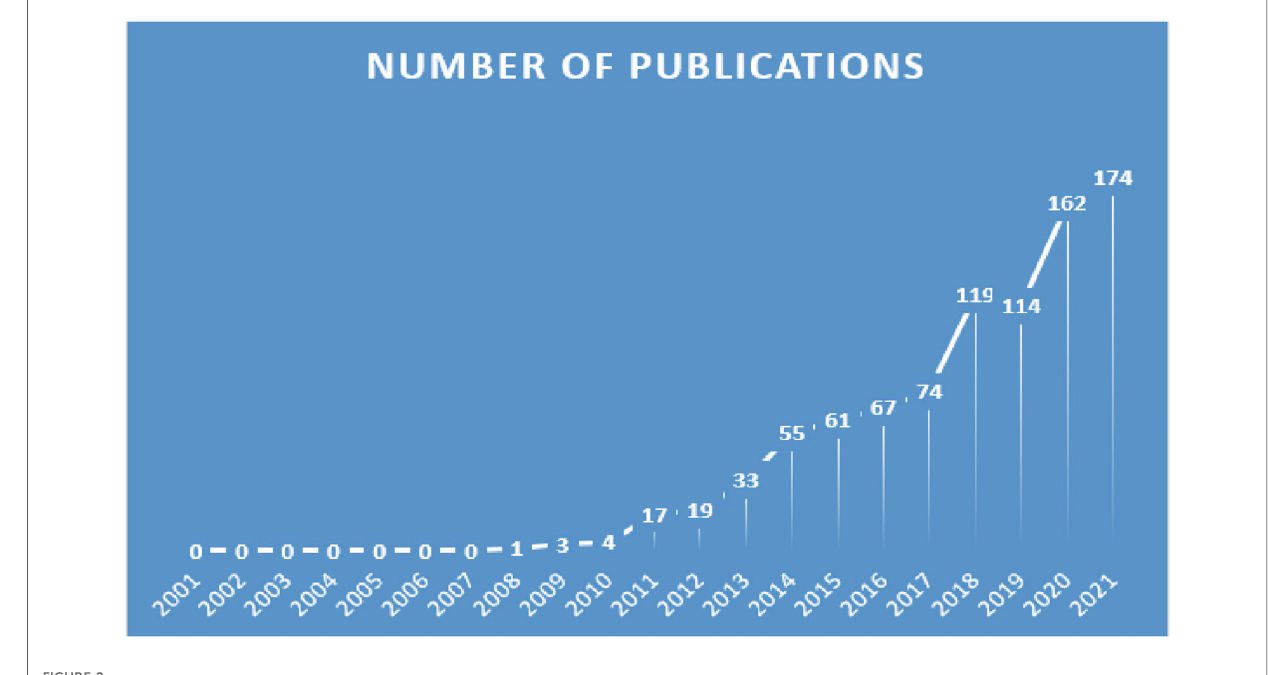
FIGURE 2 Trends of in fl ammasomes published in atherosclerosis studies over the past 20